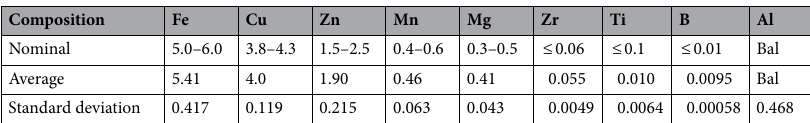
Table 2. Chemical composition of electromagnetic stirred billets for this study